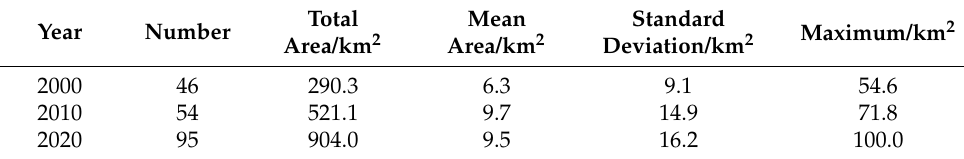
Table 2. Statistical description of the Wen-Tai